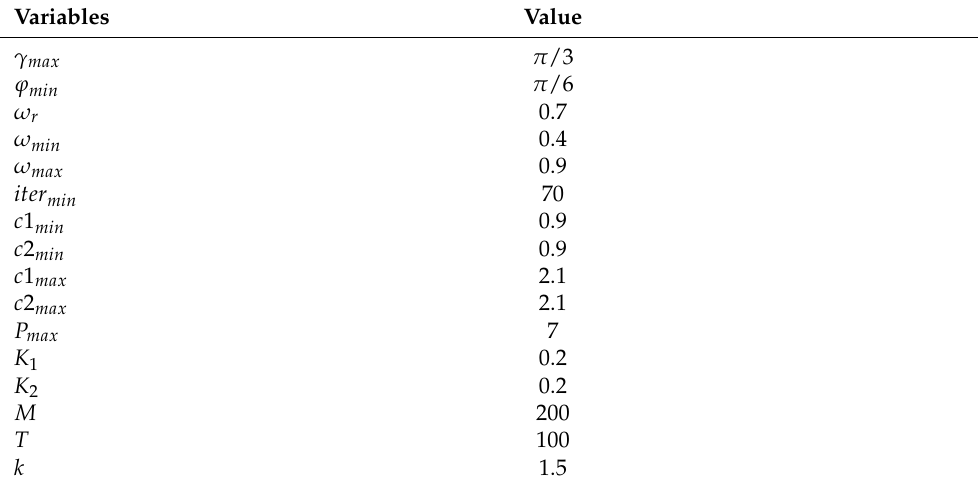
Table 1. The parameters of the improved SPSO-2011